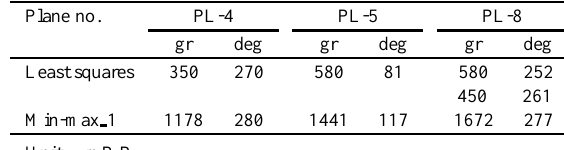
Table 5 Comparison of weight distributions for the nuclear turbine